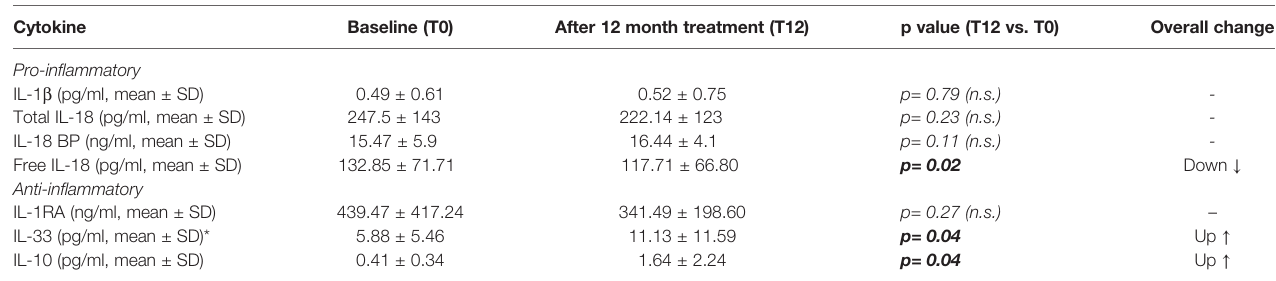
TABLE 2 | Changes in cytokine serum levels of amnestic MCI patients supplemented with homotaurine.